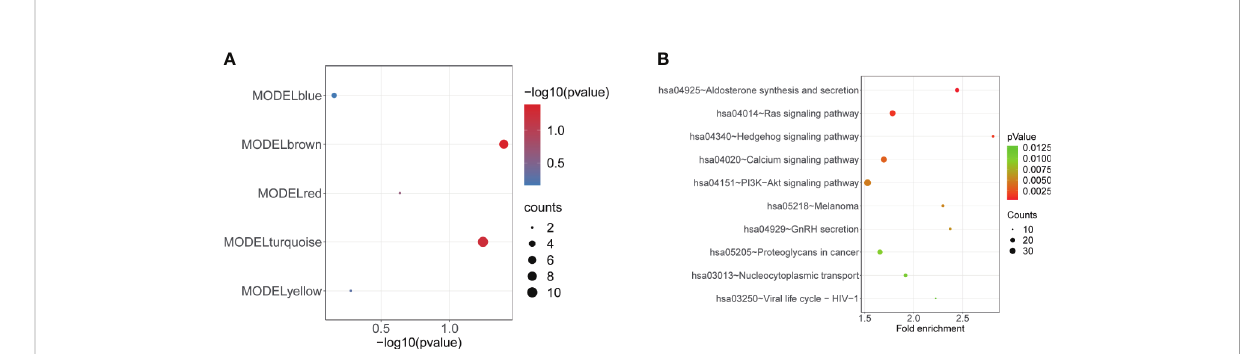
FIGURE 6 Enrichment analysis of the MEbrown module. (A) Bubble plot showing the enrichment of m6A targets in each module (MEblue, MEbrown, MEyellow, MEred, and MEturquoise). (B) Bubble plot indicating the KEGG pathways of MEbrown.